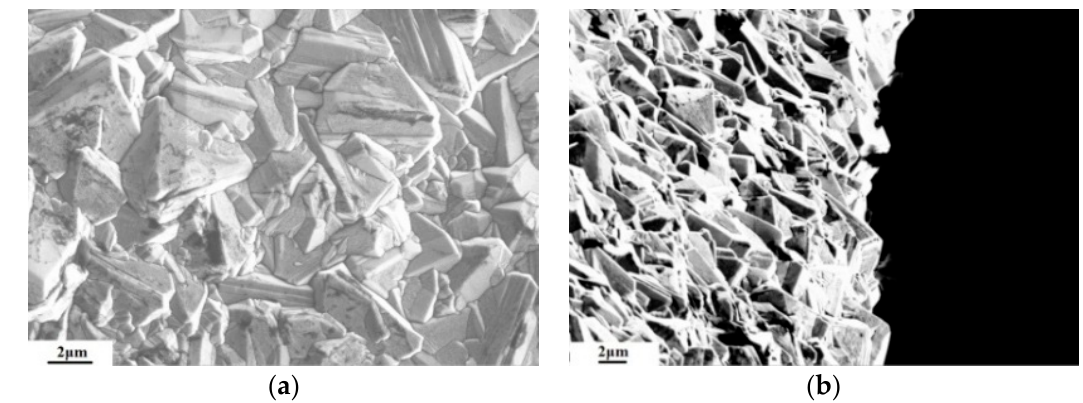
Figure 1. Morphology of microcrystalline diamond (MCD) coated tool. ( a ) Tool surface; ( b ) cutting edge.